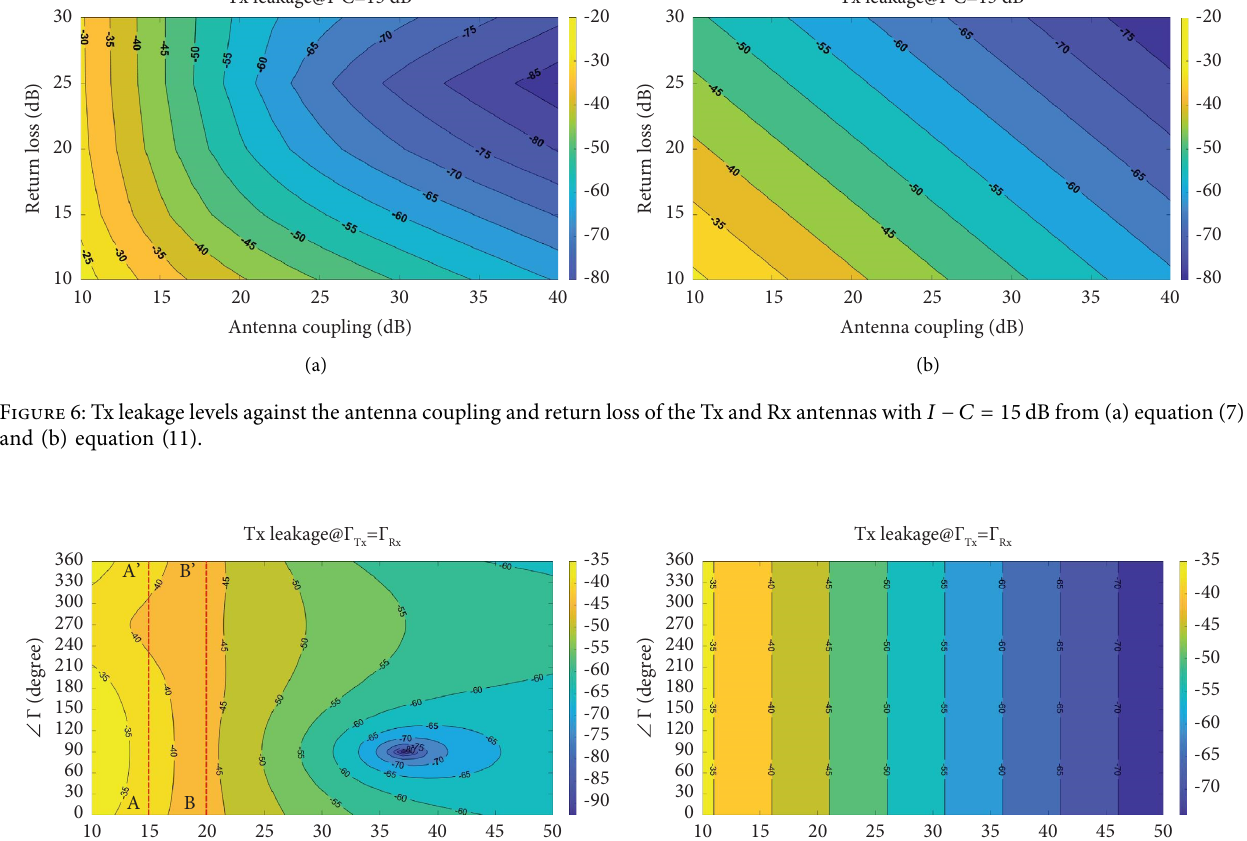
� Γ Txa Rxa from (a) equation (7) and (b)